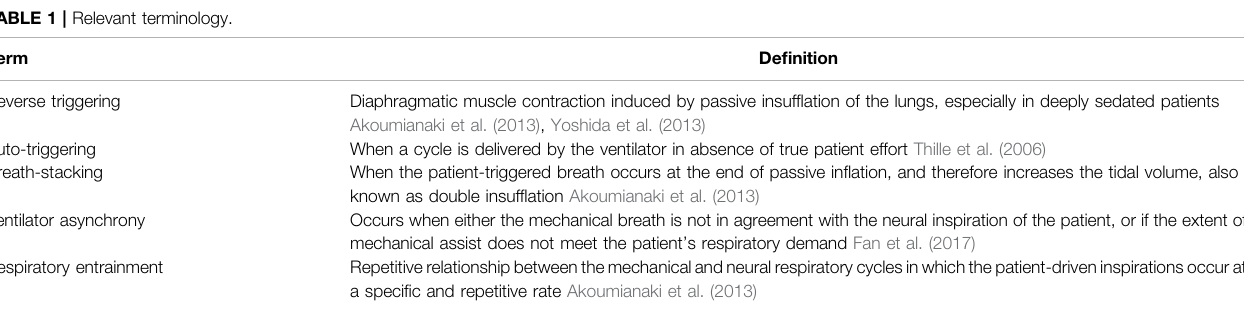
TABLE 1 | Relevant